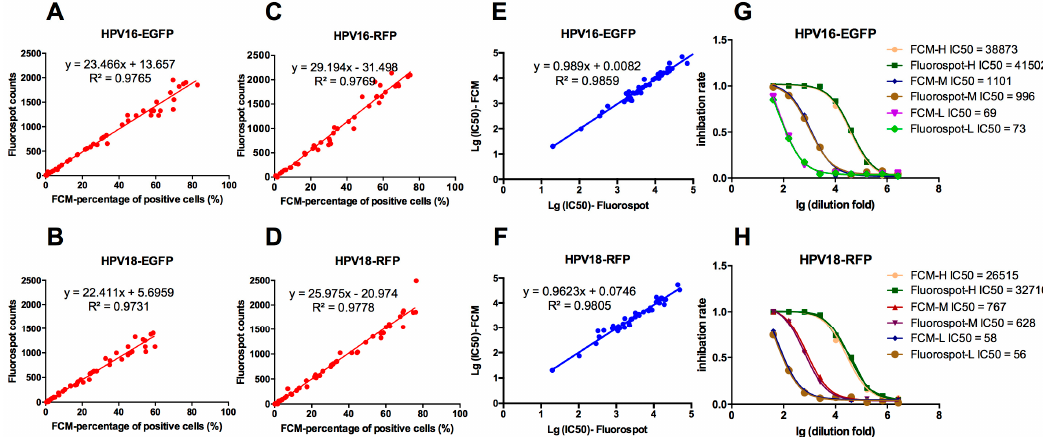
Figure 2. Correlation between FluoroSpot and FCM analyses of EGFP- and RFP-PBNA. ( A – D ) Correlation of the Fluorospot counts and FCM-percentage of positive cells when tested for HPV16-EGFP, HPV18-EGFP, HPV16-RFP and HPV18-RFP, respectively; ( E , F ) correlation of the lg(IC50) values for Fluorospot counts and FCM-percentage of positive cells when tested for HPV16-EGFP and HPV18-RFP, respectively; ( G , H ) the titration of three serum samples (H, M, and L with high, medium, and low neutralizing antibody titers collected from the dual-valent vaccine clinical tiral) against HPV16-EGFP and HPV18-RFP, respectively. The sensitivity parameters used in these assay was 215.